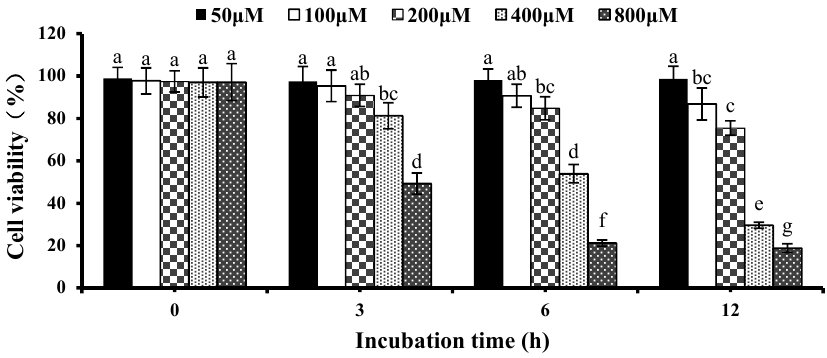
Figure 1. Effects of H 2 O 2 on cell viability in HepG2 cells. Cells were treated for 3, 6, and 12 h, respectively, with different concentrations of H 2 O 2 . The results are presented as the means ± SD of three independent experiments. Means with different letters are significantly different from each other at p < 0.05.